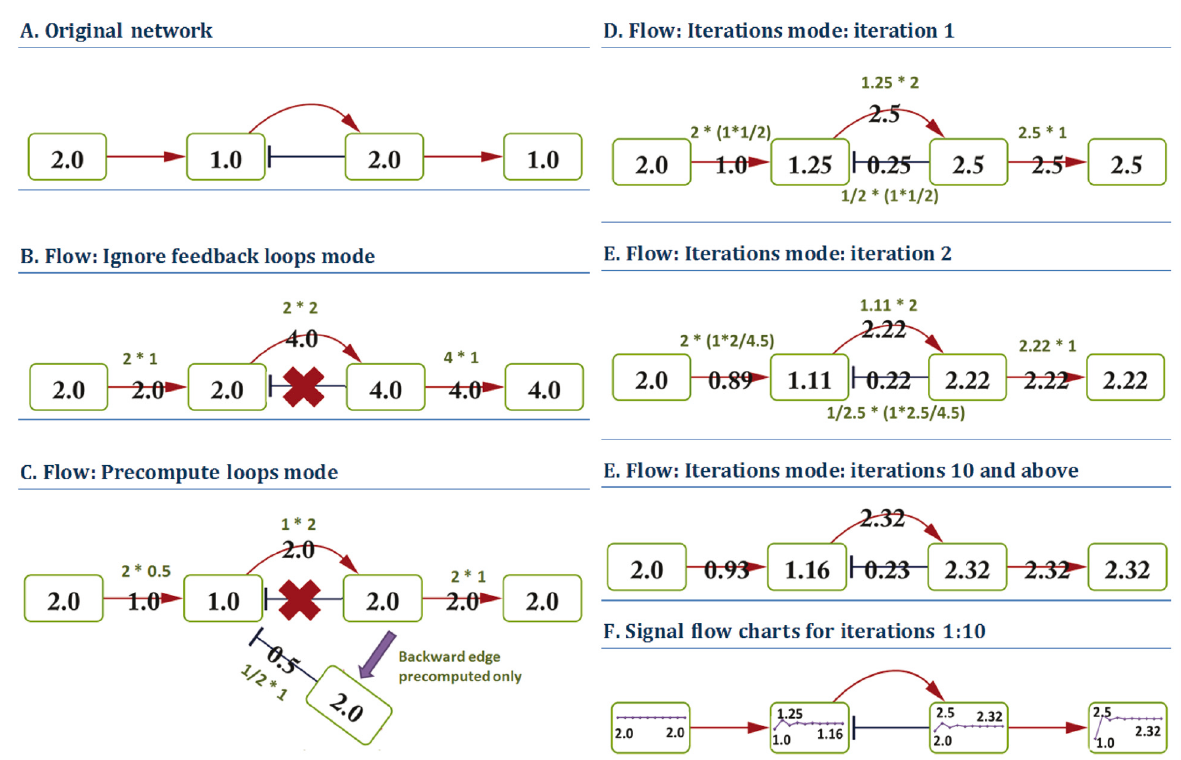
Figure 3. Signal flow calculation on a sample network with different options for loop handling. The PSF flow rules are: for red edges of type activation (*): source * target ; for blue edges of type inhibition (/): 1/source * target ; Multiple input signals: Addition ; Splitting: Proportional ; Split on: Incoming edges . The “Ignore feedback loops” mode ( B ) does not account for backward edges. In the “Precompute loops” mode ( C ), the backward edge signal first updates the target node value, and is ignored in the following single iteration. ( D – E ): signal flow at different iterations with “Iterate until convergence” mode. The network converges at iteration 10. The dynamics of flow changes at each node during 10 iterations are shown as line charts in ( F ). Edges ignored during the computation are indicated by red X